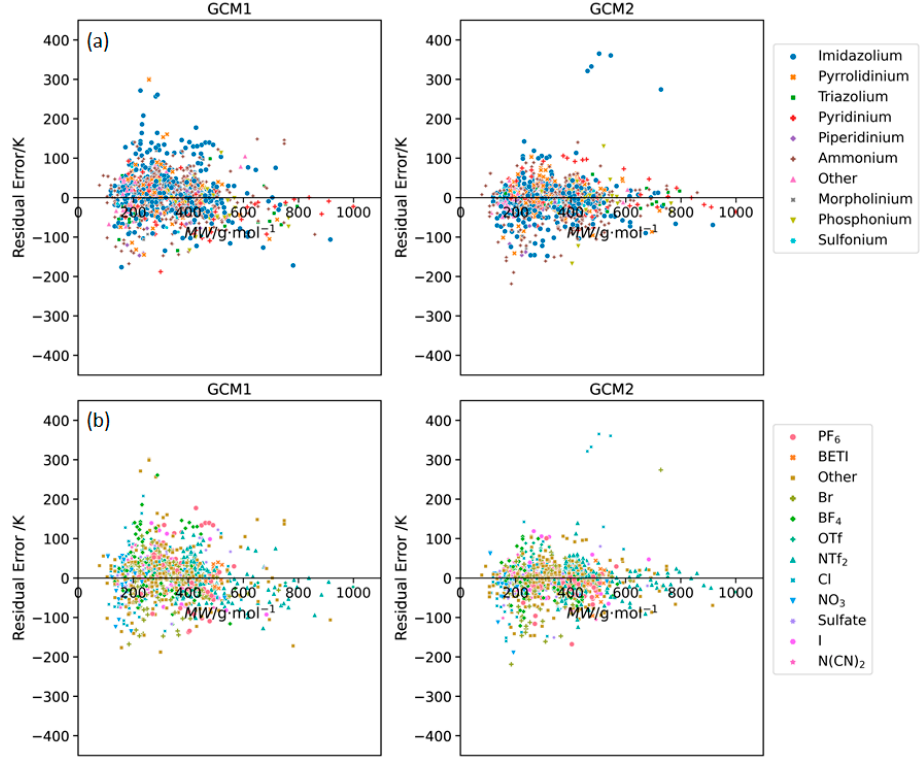
Figure 3. Residual plots of error versus IL molecular weight obtained using GCM1 and GCM2 to estimate melting points for ILs containing the major ( a ) cation and ( b ) anion types.